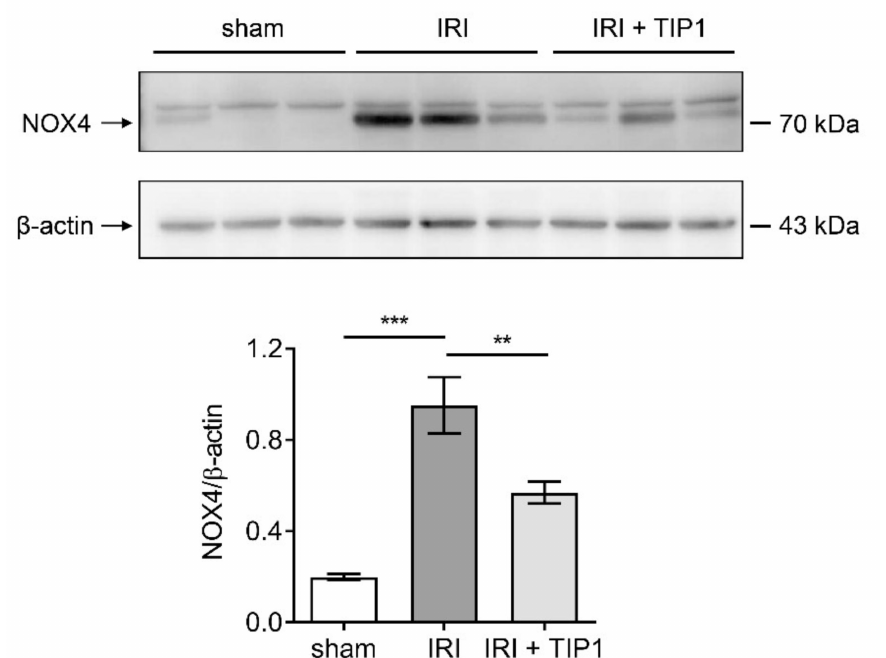
Figure 6. Inhibitory effects of TIP1 on oxidative stress in a renal ischemia-reperfusion model. NOX4 levels were quantified by western blot in kidney tissues from sham ( n = 6), IRI ( n = 6), and IRI-TIP1 ( n = 6) groups. β -actin from the same membrane was used for densitometry. Data are expressed as mean ± SEM. ** p < 0.01, *** p < 0.001. TLR-inhibitory peptide 1 (TIP1); NADPH oxidases 4